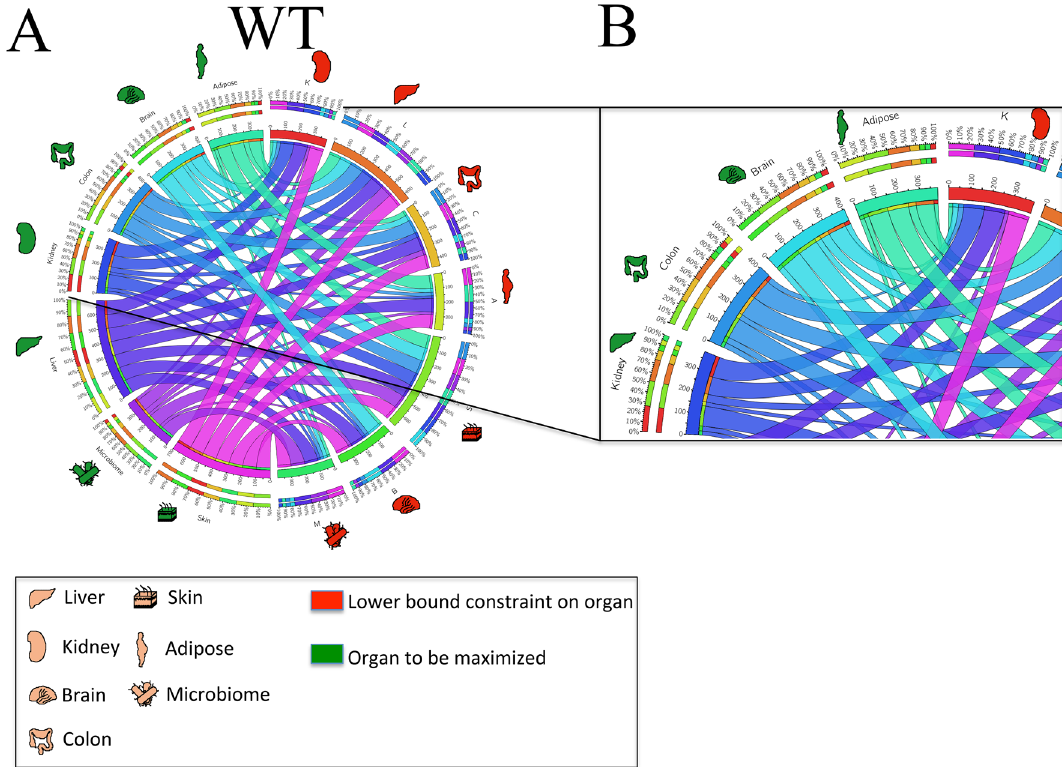
Figure 10. Organ-organ interaction and metabolic interdependence for OAT3 WT and KO models. The models were analyzed to assess the influence that different organ metabolic objectives had on one another and whether these changed with the loss of OAT function. The Circos plots illustrate direct pairwise interactions and the consequences of reaching a particular organ’s metabolic objective while being directly constrained by a different organ. The red shaded organ icons can be viewed as the output constraining effect, and the green shaded organ icons as the input constraining effect (‘constraining effect’ refers to a limit on a particular reaction flux as a result of competing substrates for a different metabolic reaction). The ribbon width of each organ to its self-counterpart (i.e. red colon to green colon) serves as the ‘reference’ comparison for other organ- organ interactions. Similar ribbon widths reflect relative independence of the optimized organ. Conversely a smaller width indicates a constraining effect on the optimized organ metabolic objective. ( A ) WT Circos plot of organ-organ interactions with ribbon width corresponding to the maximum percentage of an organ’s metabolic objective while maintaining 80% of maximum for another organ. The majority of the ribbons are symmetric with similar widths. Notably there is a constraining effect of the kidney on the colon, microbiome, and brain metabolic objectives. ( B ) Zoomed in view of a section of the WT Circos plot. The outer ring scales are percentages relative to the summed total independently optimized organ objectives. The inner ring is the summed total normalized to a total value of 400. The width of the kidney-kidney ribbon serves as the reference. Note that the kidney → microbiome, kidney → colon, and kidney → brain ribbons (green → red for each respective case) are markedly thinner (approximately 1/10 each), indicating metabolic competition for each of these organs. ( C ) Knockout Circos plot of organ-organ interactions with ribbon width corresponding to the maximum percentage of an organ’s metabolic objective while maintaining 80% of maximum for another organ. Relative comparison between the WT ( A , B ) and KO ( C ) indicate changes in the inter-organ metabolic demands resulting from loss of OAT3 transport function. The kidney-colon-microbiome axis has been described, but there is a constraining effect of liver metabolism on multiple organs including the kidney, brain, and microbiome. In Supplemental Fig. 3, a similar analysis is presented for WT versus Oat1 KO. ( D ) Difference (in percentages) between the WT and KO Circos plots. The quantitative percentage differences between the organ- organ interactions for WT ( A , B ) and KO ( C ) in panel ( D ) provide an objective assessment of the changes in the inter-organ constraints due to loss of OAT3. The most prominent changes are seen for the liver, colon, and skin. ( E ) Kidney-liver-colon flux cone. The 3D flux phase plane depicts the trade-offs among three competing organ objectives, the kidney, liver, and colon. It is interesting to note that, in comparing the WT and KO, although the liver-kidney slope is curtailed, the metabolic flexibility for the colon is severely restricted. Legend: Labels for the different organ icons are described. Red shading reflects the organ that has been constrained with a lower bound equal to 80% of its maximum value. Green shading demarcates the organ metabolic objective that is optimized. Abbreviations (corresponding to the organ icons): L liver, K kidney, B brain, S skin, A adipose, C colon, MB